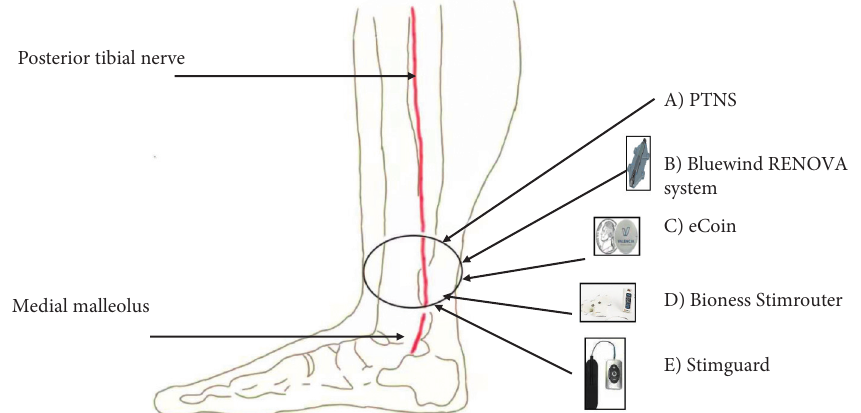
Figure 2: Posterior tibial nerve anatomy and site of different stimulation modalities. (A) The PTNS needle location; (B) BlueWind RENOVATM device; (C) eCoinTM device; (D) Bioness StimRouter; and (E)